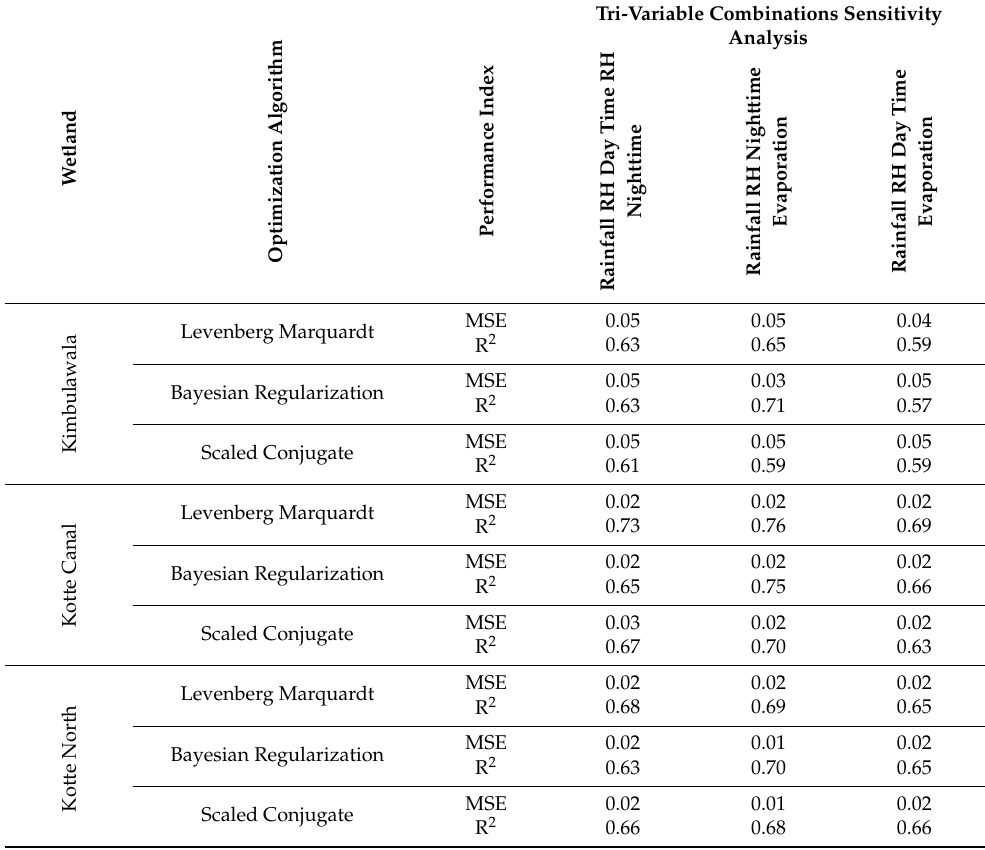
Table 3. Results of tri-variable sensitivity